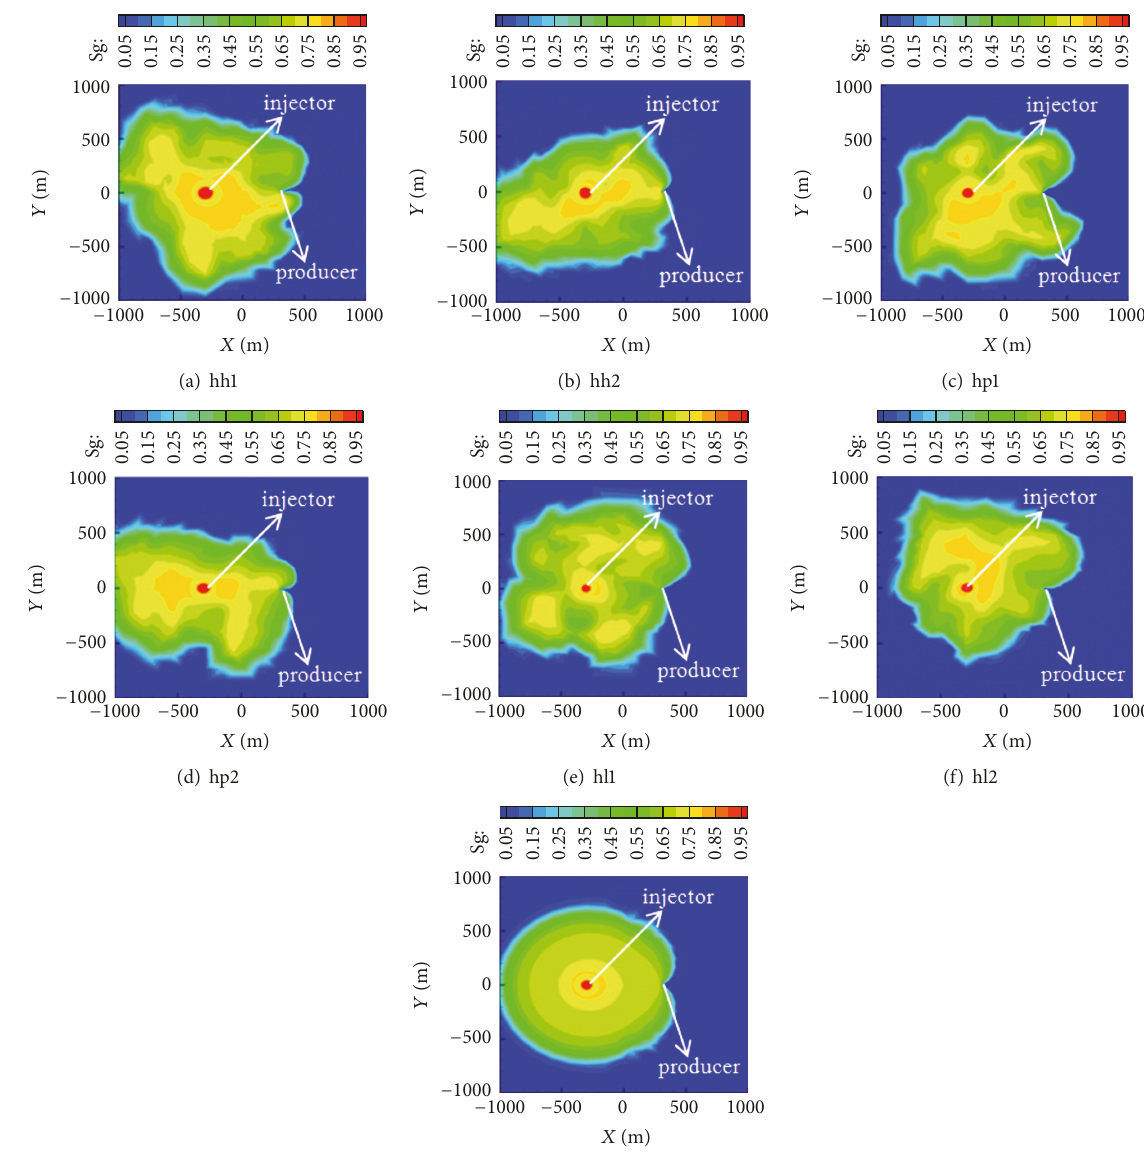
Figure 3: Carbon dioxide saturation distribution in the cross-section of subdomain in the depth of 3050 m for different cases after 3 years.